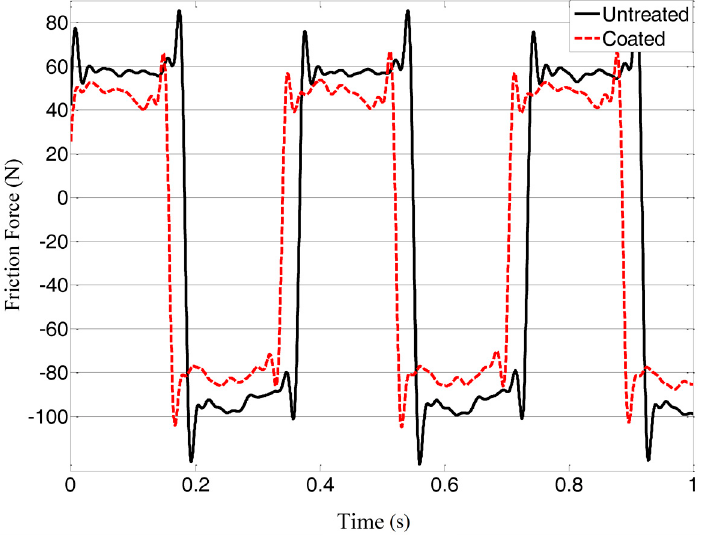
Figure 4. Comparison of observed friction force of coated and untreated piston rings.